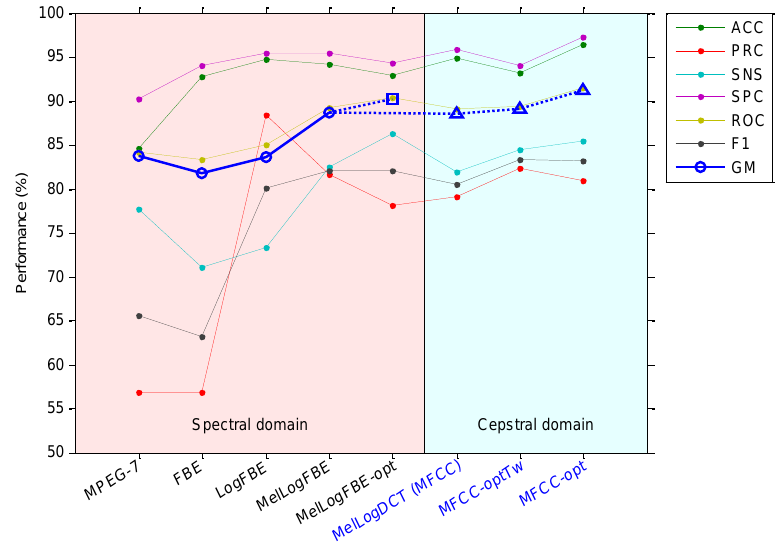
Figure 31. Classification performance using various alternatives for the representation of the anuran call spectrum.